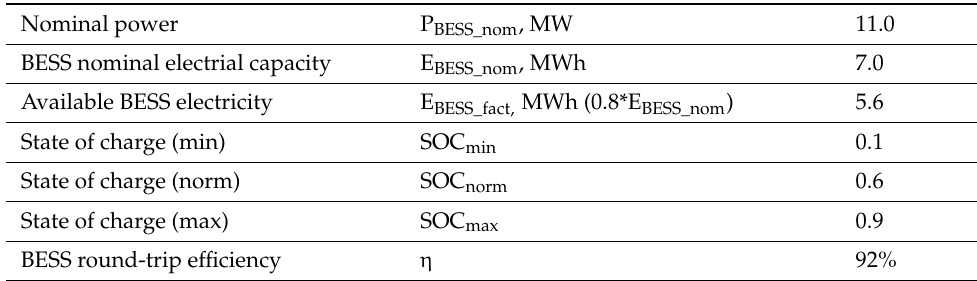
Table 4. Selected BESS